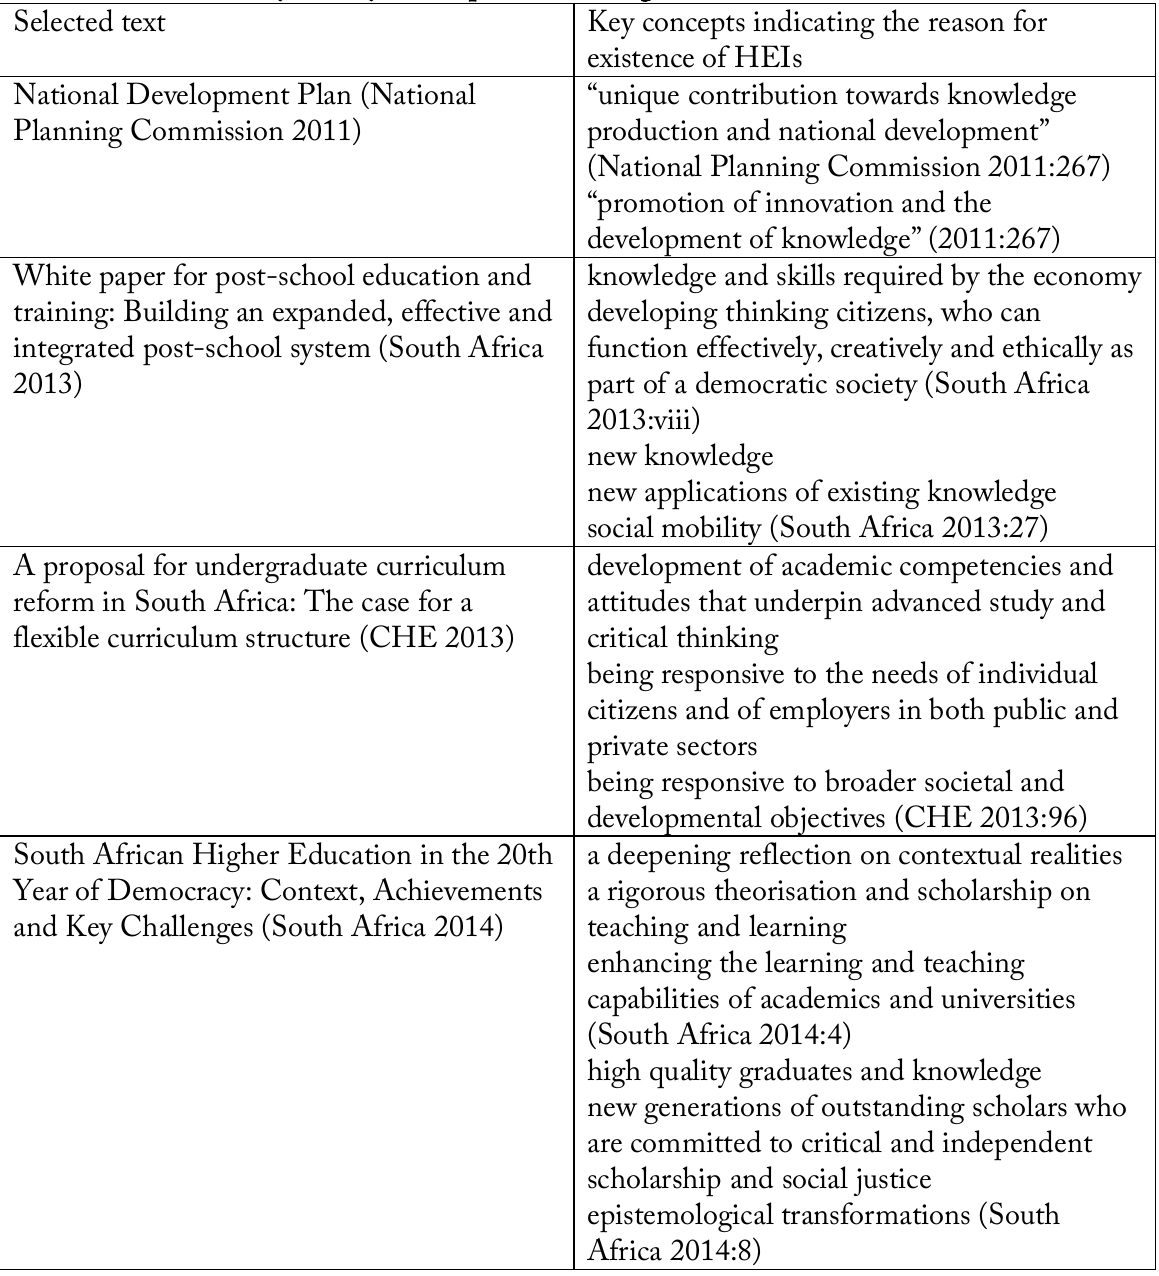
Table 1: Summary of key concepts indicating the reasons for existence of HEIs Selected text Key concepts indicating the reason